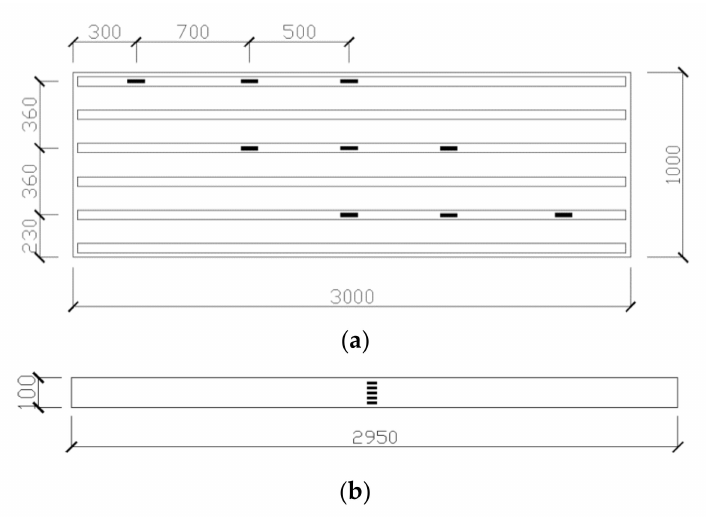
Figure 3. Schematic diagram of measuring points on cold-formed thin-walled C steel channels. ( a ) Location of the strain gauges at the top and bottom flanges of the cold-formed thin-walled C steel channels; ( b ) location of the strain gauges at the webs of the cold-formed thin-walled C steel channels. In addition to measuring of the strains in the cold-formed thin-walled C steel channels, there were 10 strain gauges on the upper surface of foam concrete, 4 of which were in mid span, 4 at three points on both sides, 2 at the two ends near the support, and 5 strain gauges were placed along the section height according to the position of the lower surface and the strain gauges on the upper surface. The strain gauges used for measuring foam concrete are shown in Figure 4.